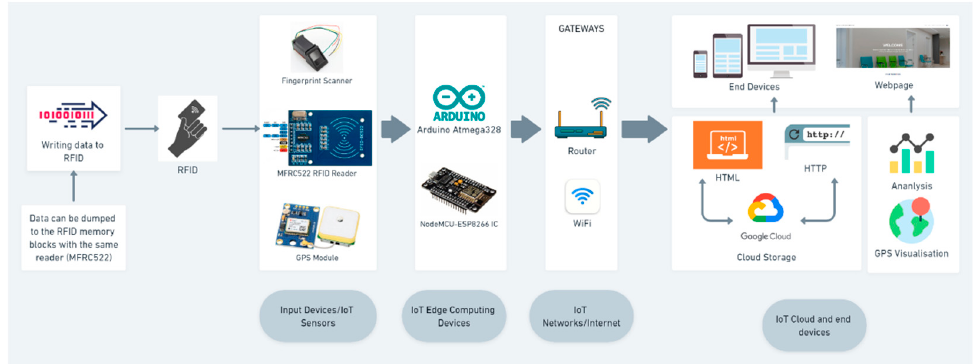
Figure 2. Data flow architecture of the proposed